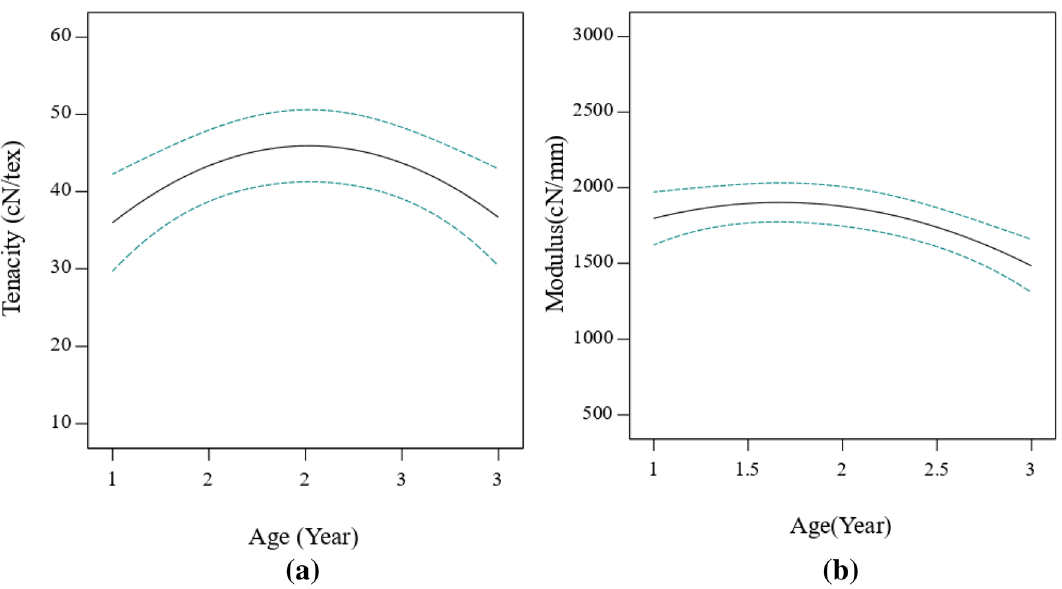
Fig. 8 Eq. (1) for concentration 12% and soaking time 2 days, solid line Dash lines show one standard deviation. a Age versus Tenacity b Age versus Modulus